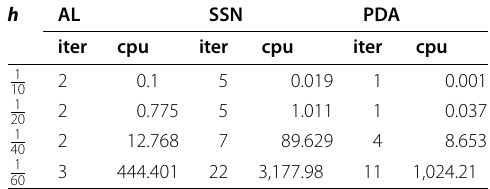
Table 3 Comparisons of iteration numbers and execution times for Problem